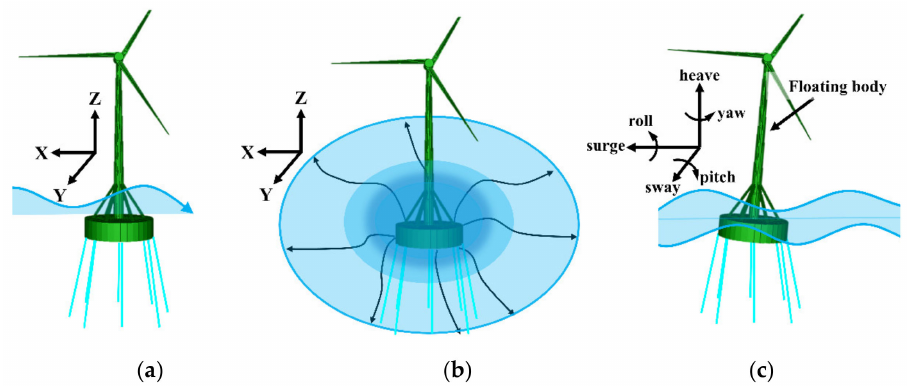
Figure 1. The hydrodynamic response of floating body in waves. ( a ) Diffraction response, ( b ) radia- tion response, and ( c ) hydrodynamic